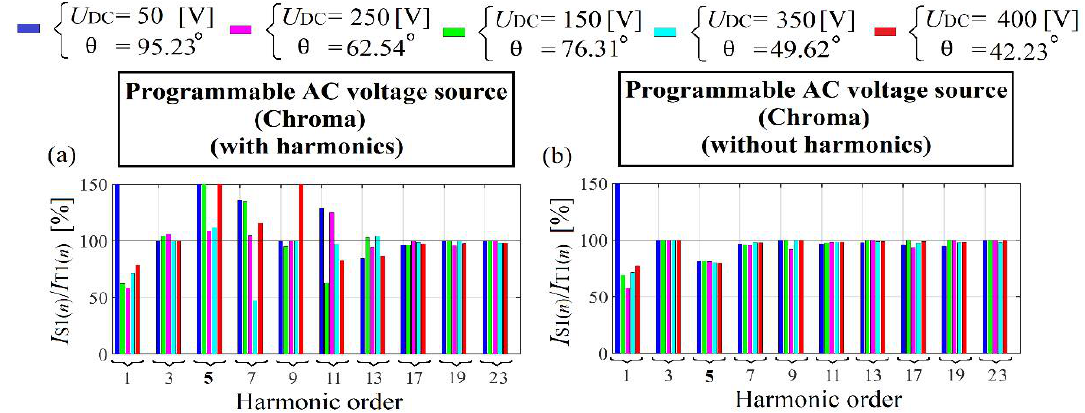
Figure 29. Comparison between the spectrums of filter efficiency: ( a ) programmable voltage source with harmonic, ( b ) programmable voltage source without harmonics.